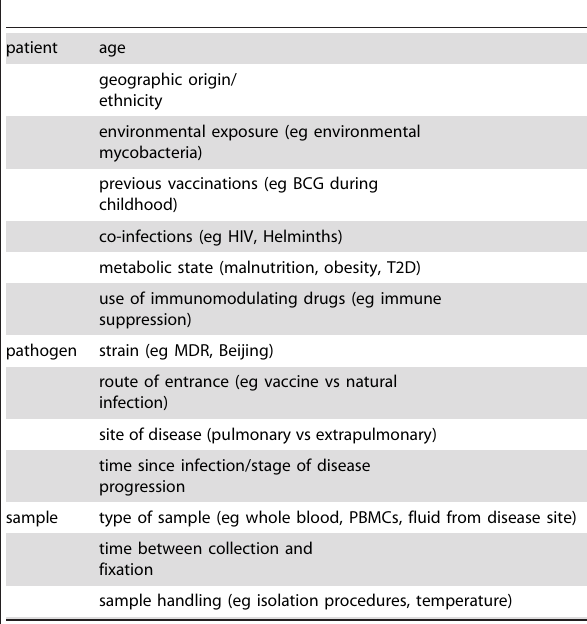
Table 1. Factors that may affect TB